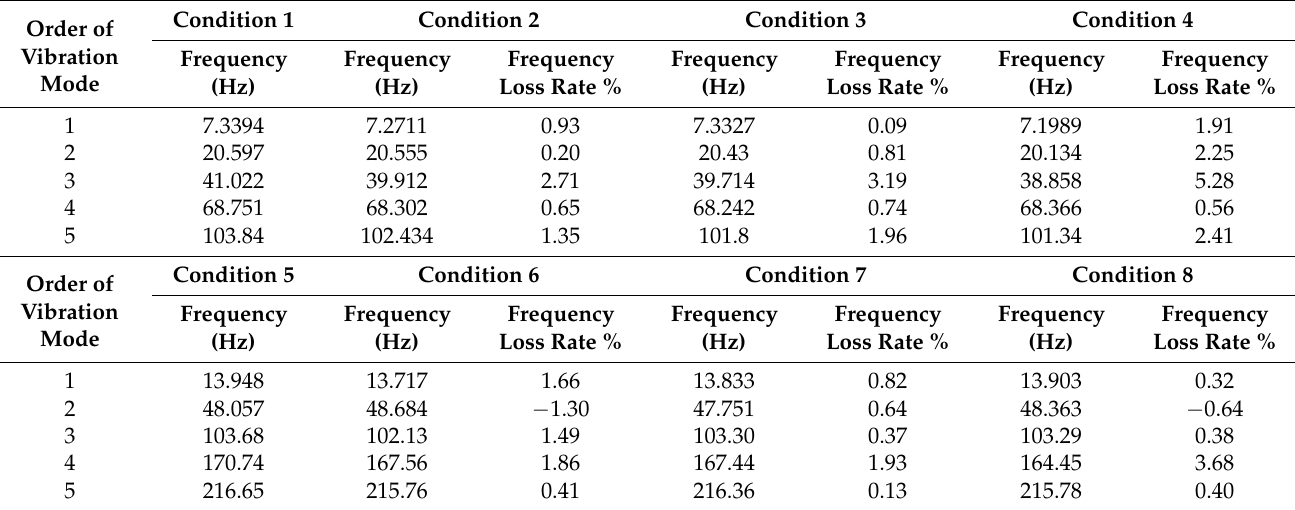
Table 6. Inherent frequency loss rates at different